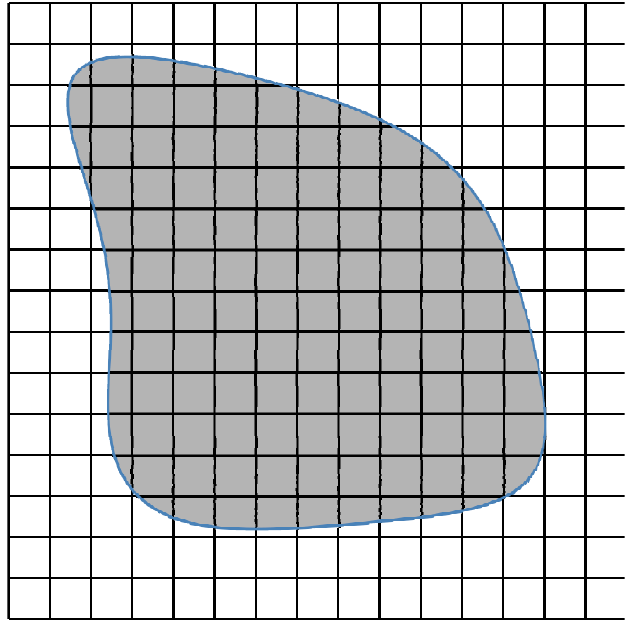
Figure 2. Discretization of a particle volume in the discrete-dipole approximation (DDA) method.